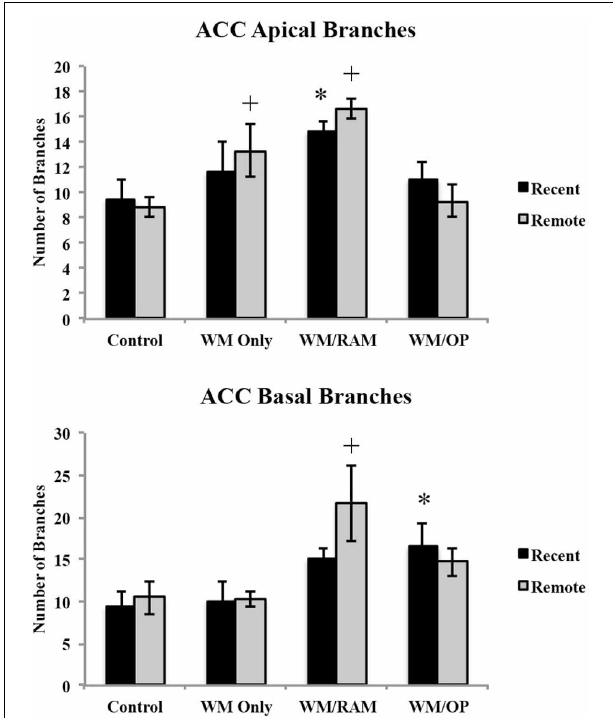
FIGURE 4 | Total number of branches in the ACC in apical and basal dendrites. Only significant differences between behavioral groups and their respective control group are displayed. Refer to Results section for all comparison results. ∗ Significantly different from Control:Recent group ( p < 0 . 05); + Significantly different from Control:Remote ( p < 0 . 05).